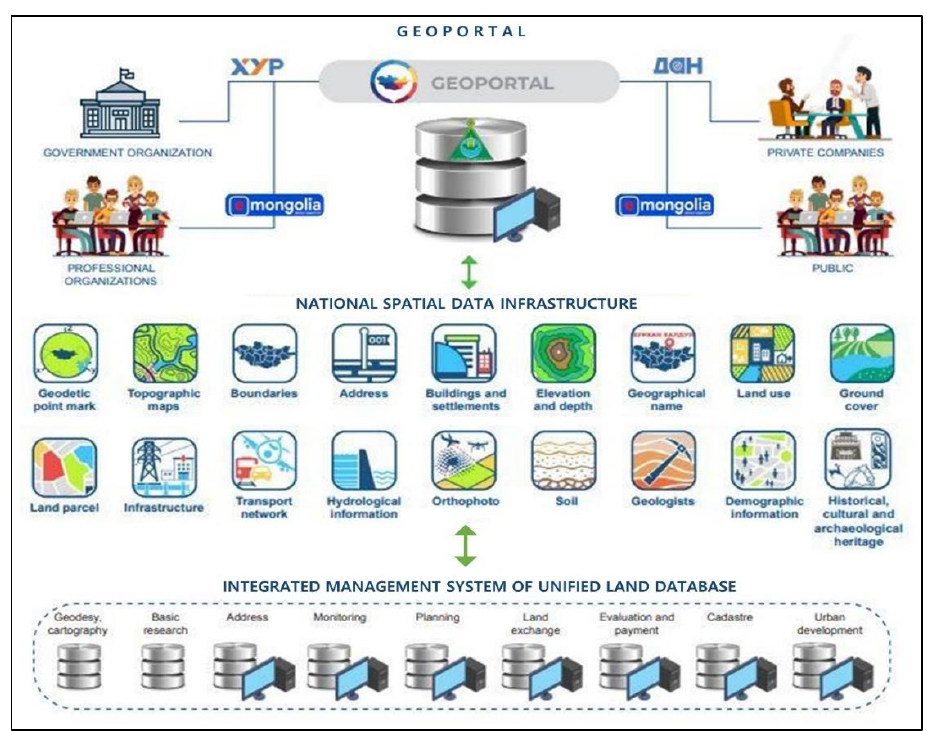
Figure 4. National geo-standards and their relation to geoportal and SDI. Adapted from [32].